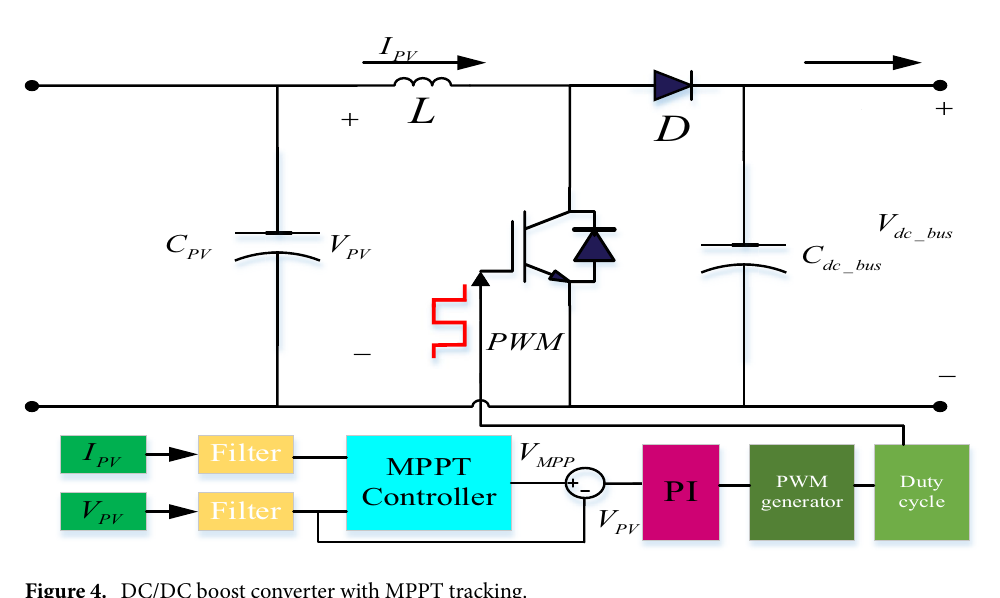
Figure 4. DC/DC boost converter with MPPT